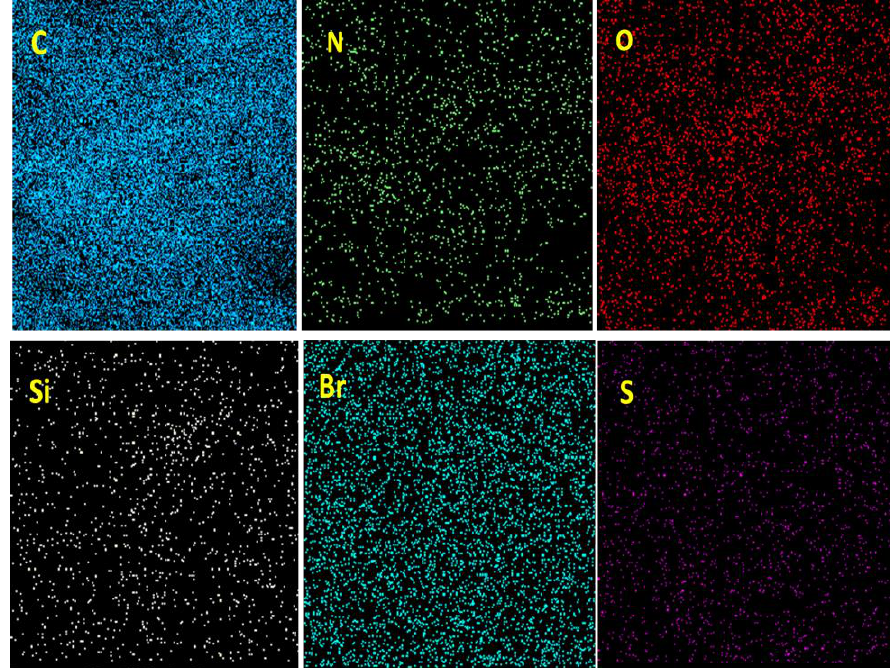
Figure 4. Elemental mapping analysis of BC@GCN-P-IL.